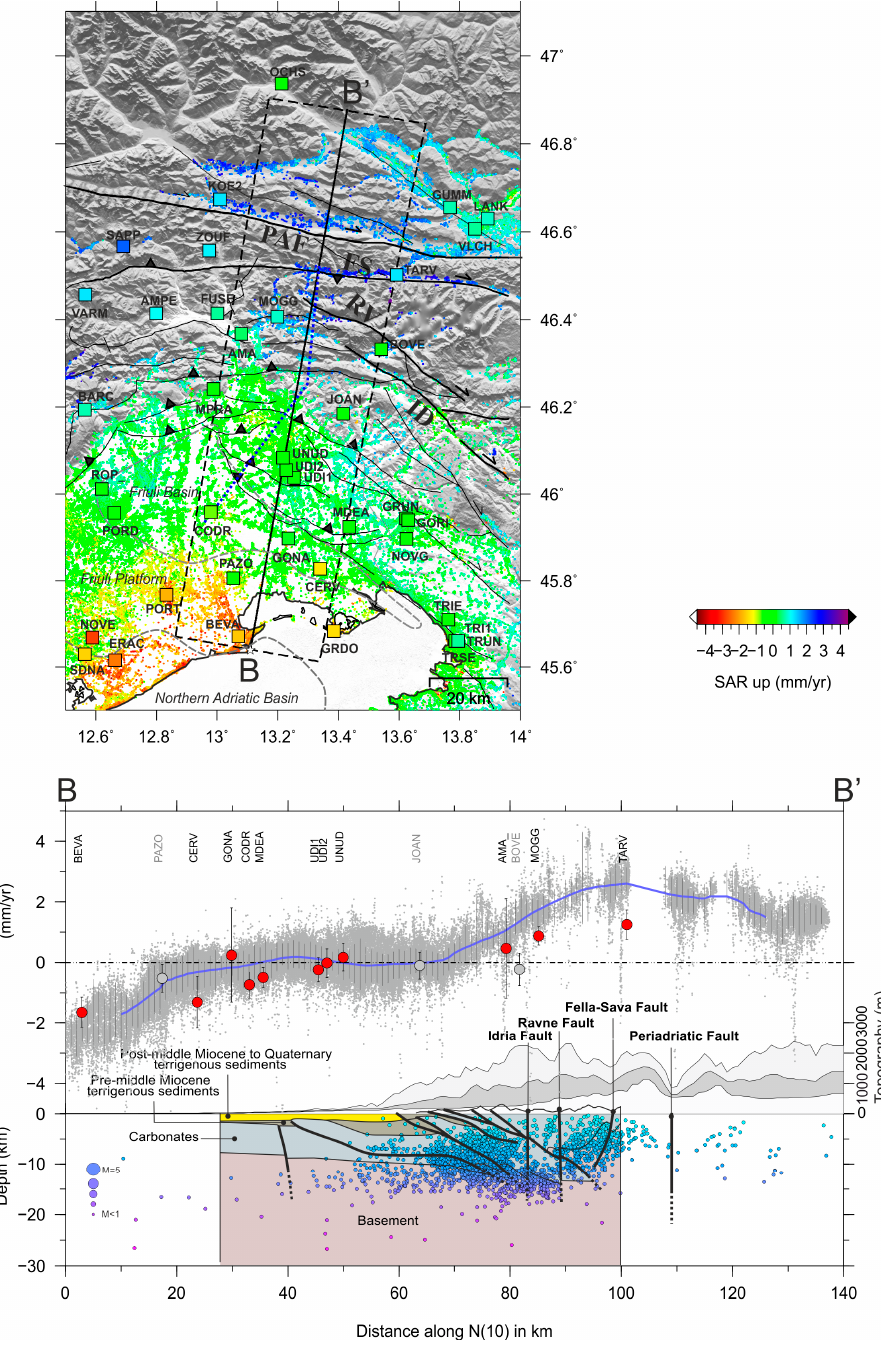
Figure 7. Vertical velocity profile across the Alpine (Carnic and Julian Alps) and Dinaric system. Top : the map shows the vertical velocity values for each PS, while the colored squares indicate the vertical velocity of the GNSS stations, according to the InSAR multicolor scale on the right (blue = uplift; red = subsidence). The blue dotted line represents the trace of the geological section reported below. The profile with a buffer of 20 km is 140 km long, and the white star indicates the starting point. Bottom : the plot shows the vertical SAR velocities (grey dots), whereas the blue line indicates the median value. The circles with relative uncertainties represent the vertical velocities of GNSS stations; specifically, the grey ones have not been used during the calibration. The geological section is modified from Merlini et al. [114].